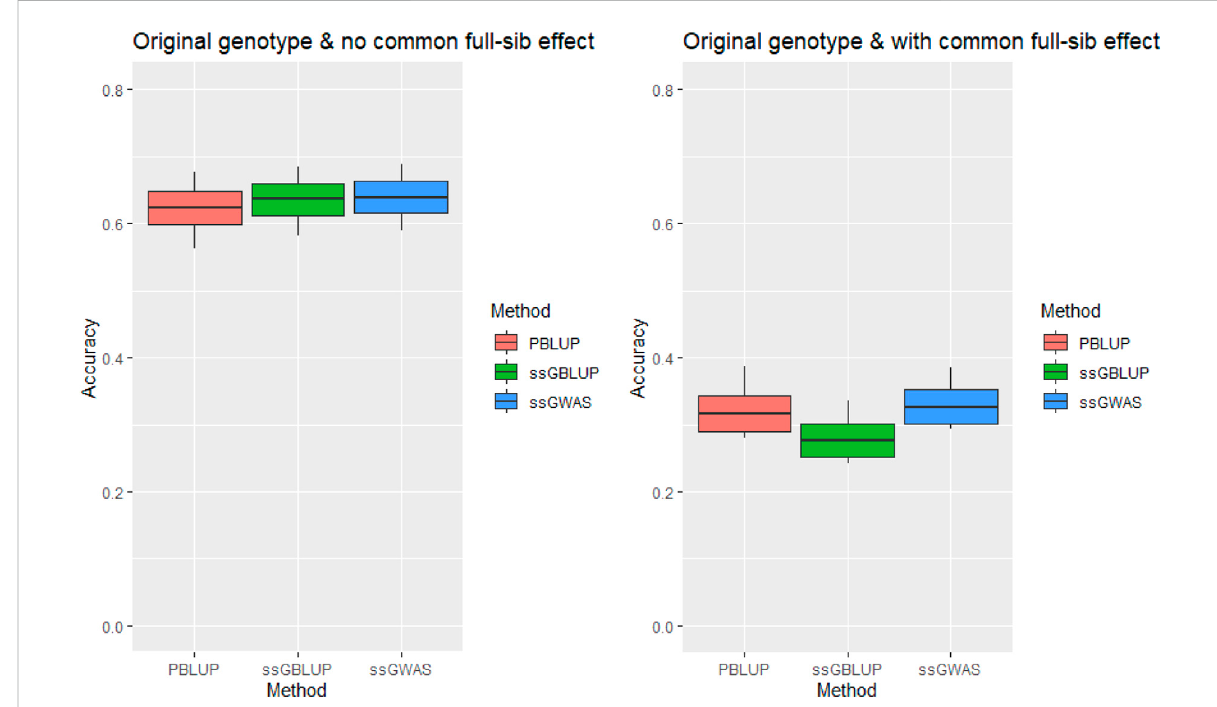
FIGURE 1 Accuracy ofgenomicpredictionfor taggingweight without/withcommonfull-sibeffect ( c 2 )usingoriginalgenotypeunderAI-REML algorithm. Middle line of the box is mean accuracy; top and bottom lines of the box is accuracy ± one standard deviation. End points of vertical line represent minimum and maximum